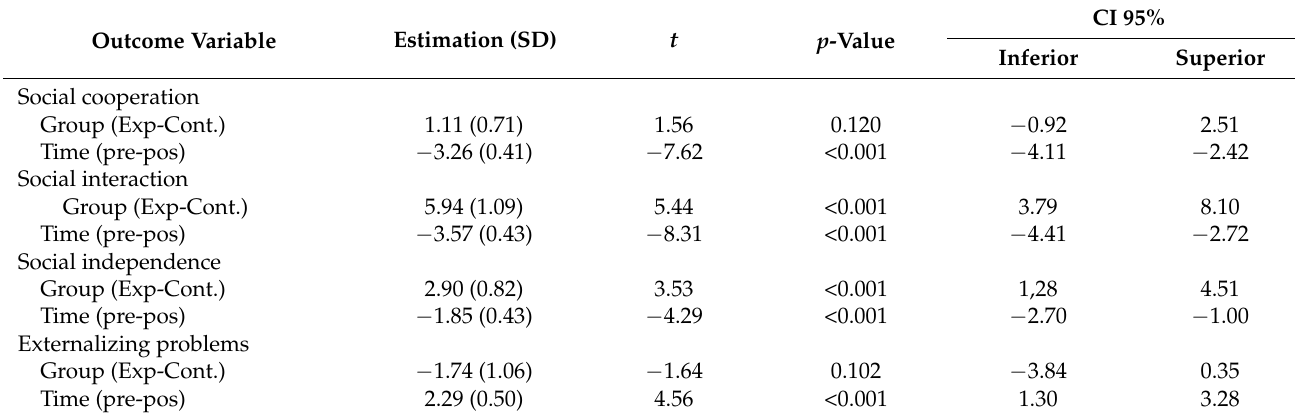
Table 7. Pairwise contrast of groups and times using means estimated by the model on social skills and externalizing problems.